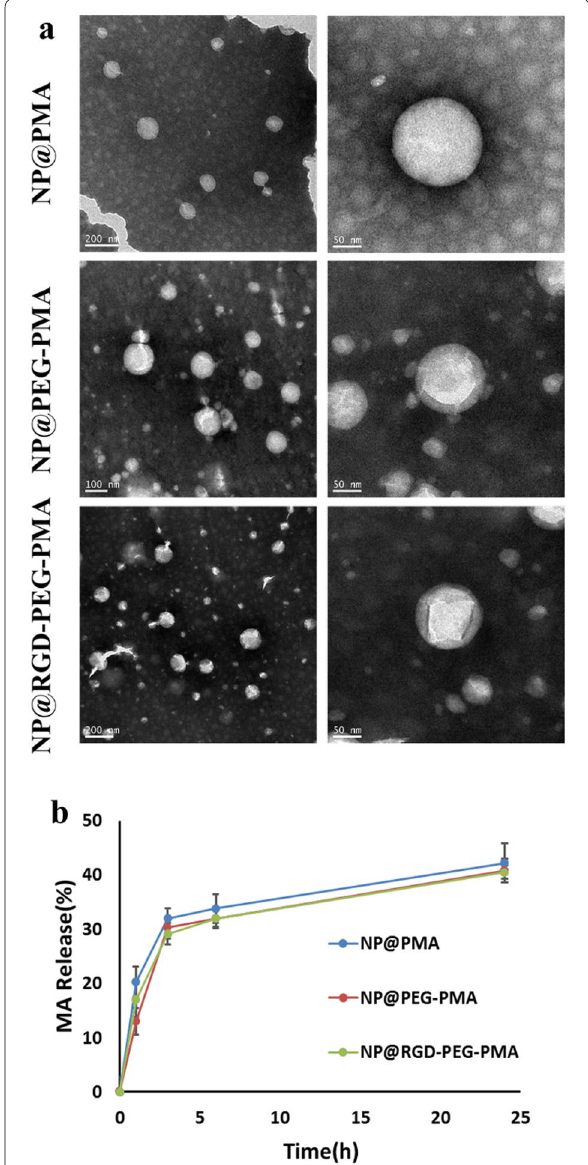
Fig. 3 Characterization of nanoparticles. a transmission electron microscope (TEM) images of NP@PMA, NP@PEG–PMA, and NP@RGD– PEG–PMA nanoparticles; b change in the release of mitoxantrone (MA) from NP@PMA, NP@PEG–PMA, and NP@RGD–PEG–PMA with time